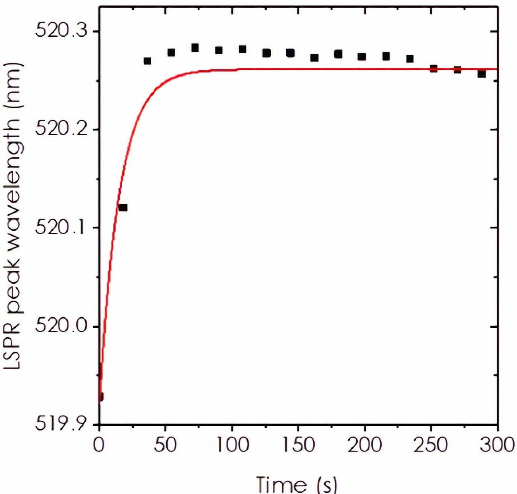
Figure 5. Evolution of the LSPR peak wavelength with time, providing information on the kinetics of functionalization of AuNPs with MUDA. Solution was not stirred during the acquisition. First, 50 µ L of MUDA at 35 µ M was added to 2 mL of AuNPs at 0.66 × 10 − 9 mol/L, leading to a final MUDA concentration of 0.86 µ M in the reacting solution. The red line corresponds to a fit of the data with a single